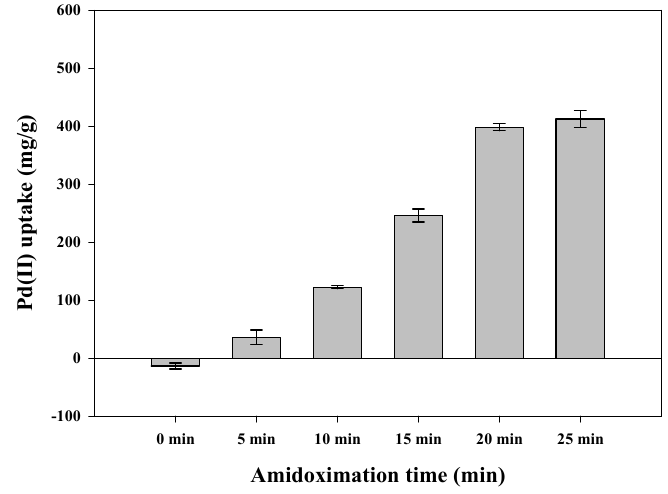
Figure 4. Effect of amidoximation time on the Pd(II) uptake by PAN–oxime fiber.